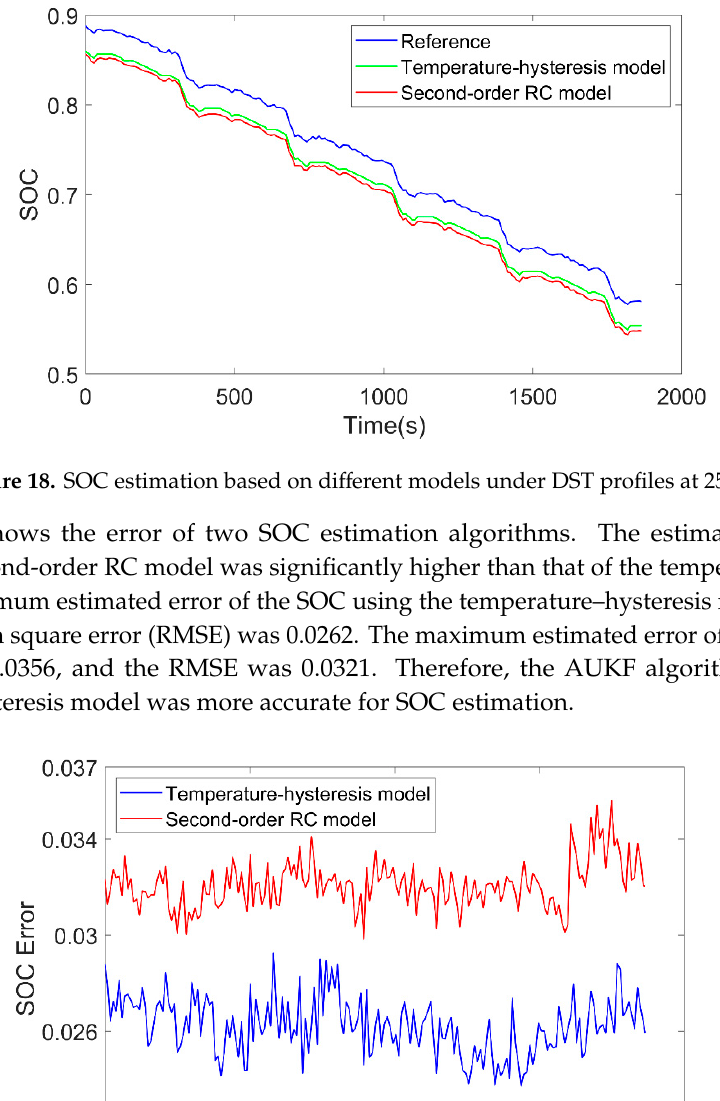
17 of 25 Figure 17. Battery models output error curve under variable temperature conditions. 4.2. Verification of the SOC and SOP Joint Estimation 4.2.1. Verification of the SOC Estimation The paper used the DST profiles in Figure 12 to estimate the SOC at a constant temperature. The SOC was estimated based on the AUKF algorithm using the temperature–hysteresis model and the second-order RC model, respectively. The initial parameters of the AUKF algorithm are shown in Table 5. As can be seen from Figure 18, the SOC estimation using the temperature–hysteresis model was closer to the value of the reference. Table 5. Parameters of the adaptive unscented Kalman filter (AUKF) algorithm. 0 x